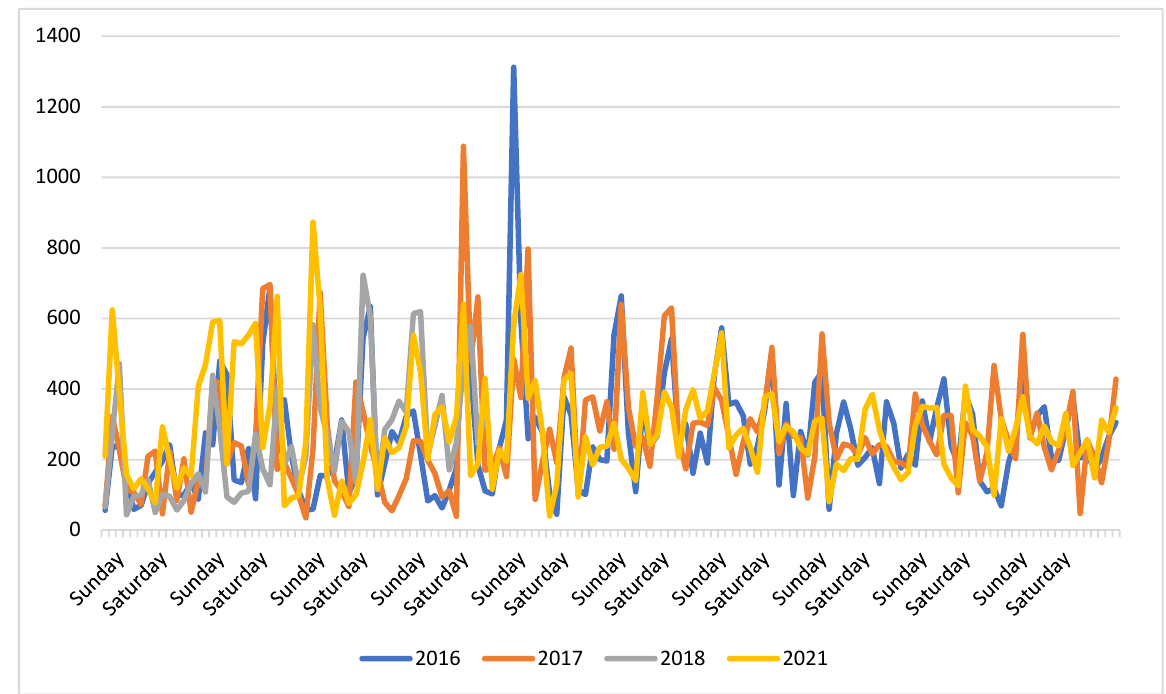
Figure 9. Forest visitors on the weekends from 2016 to 2018, and 2021 in months of March to July. (X-axis is months March to July in selected years, Y-axis is the number of forest visitors at of Training Forest Enterprise Masaryk Forest K ř tiny).